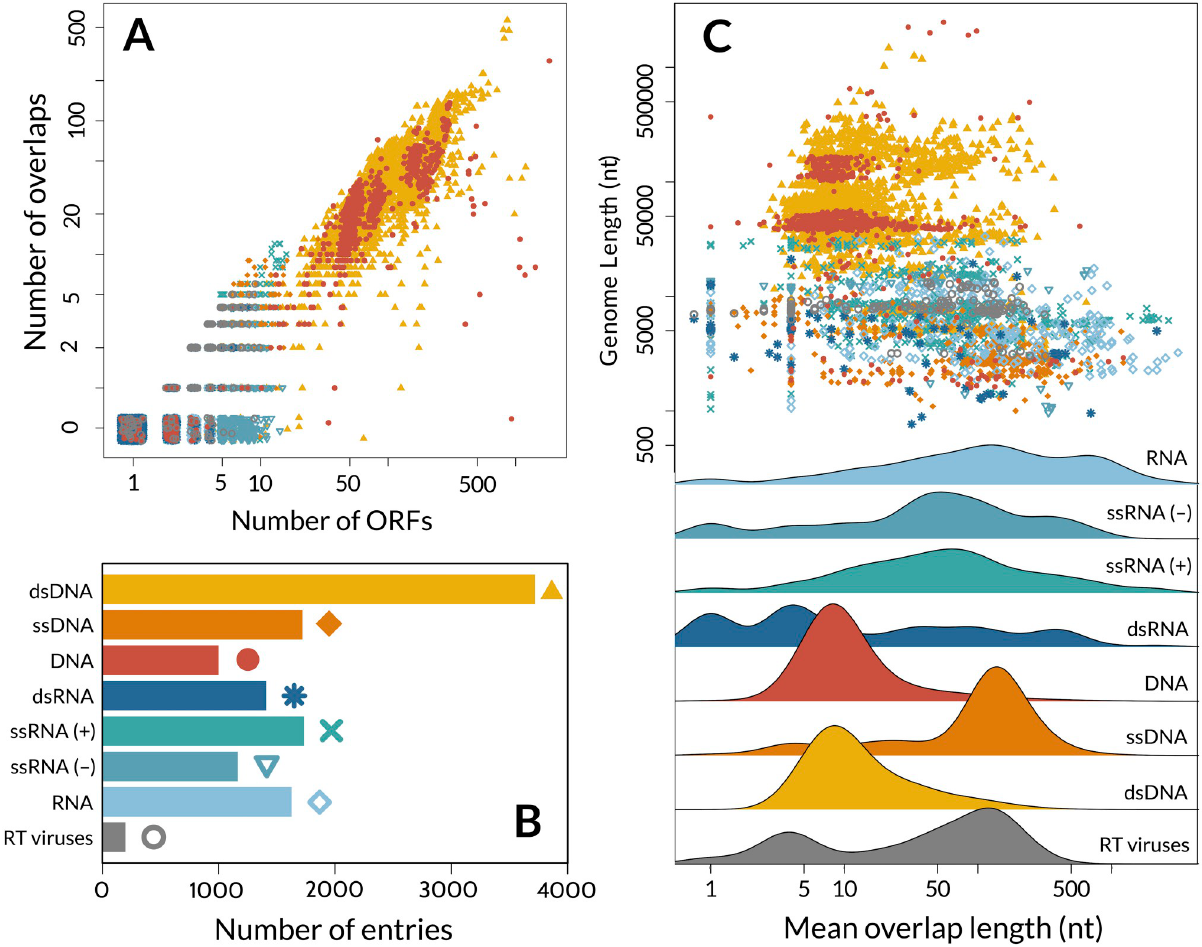
Fig 1. Distribution of overlapping genes across virus genomes. A . Scatterplot displaying a positive correlation between the log-transformed numbers of overlapping open reading frames (OvRFs) and ORFs per virus genome, stratified by Baltimore class. Genomes with no OvRFs were plotted at 0.5 (labeled ‘0’) with random noise to reduce overplotting. B . Barplot of the number of representative virus genomes per Baltimore class, which also serves as a colour and point-type legend for the scatterplots. ‘DNA’ and ‘RNA’ correspond to the molecular type annotations of virus genomes that have not been assigned to a known virus family. C . A log-log scatterplot displays the distribution of genomes with respect to overall length (in nucleotides, y -axis) and mean length of overlapping regions ( x -axis) by Baltimore class. Individual plots are provided in S2 Fig. Underneath, ridgeplots summarize the marginal distributions of genomes with respect to mean overlap lengths, to clarify differences between the Baltimore